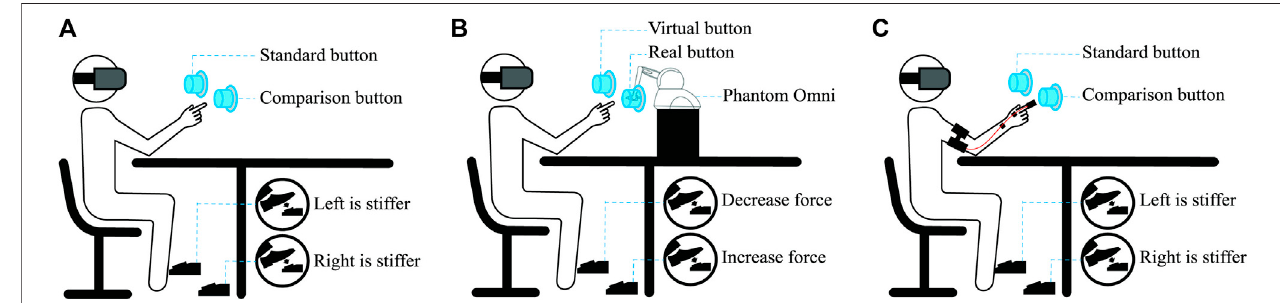
FIGURE 3 | Interaction space for the experiments. (A) General setup. The participant interacts with two virtual buttons (i.e., standard and comparison) and selects the stiffer button using the corresponding pedals under the table. (B) Setup for experiment 1. The participant interacts with two virtual buttons. The left one provides stiffness with pseudo-haptics as presented in the general setup. The right one is co-located with a robotic arm exerting veridical stiffness. The users are requested to manipulate the stiffness provided by the right button using the pedals under the table until the perceived stiffness matches the left button. (C) Setup for experiment 2. The participant interacts with two virtual buttons (i.e., standard and comparison) and selects the stiffer button using the corresponding pedals under the table. Additionally, the buttons were enriched with tactile and proprioceptive feedback using the wearable modules strapped (i.e., Velcro closures) around the exterior side of the upper-right arm, and actuators instrumented in the forearm and the index fi